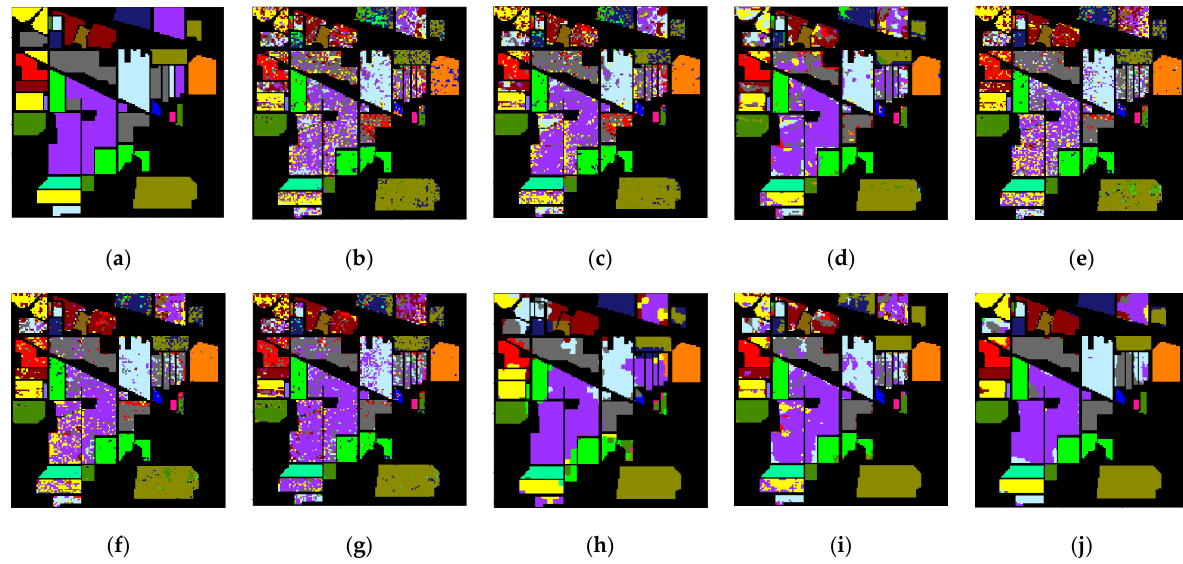
Figure 8. Classification map of various algorithms in the Indian Pines data set (( a ) Gound-truth map; ( b ) KNN; ( c ) SVM; ( d ) 2D-CNN; ( e ) CNN-PPF; ( f ) GCN; ( g ) miniGCN; ( h ) MDGCN; ( i ) FuNet-C; ( j ) SSOGCN).